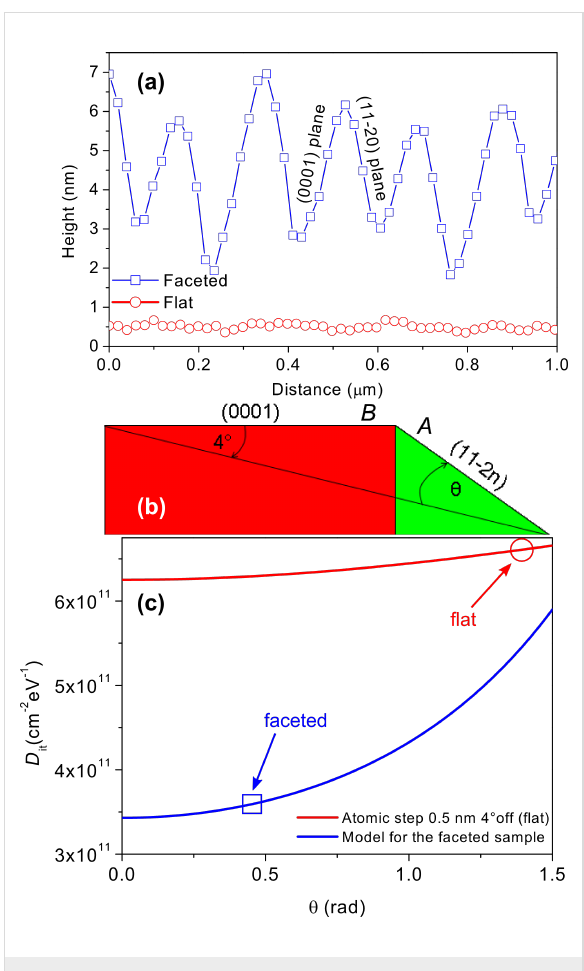
Figure 3: (a) AFM single scan line taken on the surfaces of the faceted and flat samples. (b) Schematic cross section of the basal-plane–facet orientation considering a 4° off-axis cut angle. (c) Simulated density of interface states for the ideal case and single atomic steps (red), and including the experimental measured facets (AFM section) changing the θ (11 − 2 n ) facet orientation (blue). The calculated values are compared with the experimental